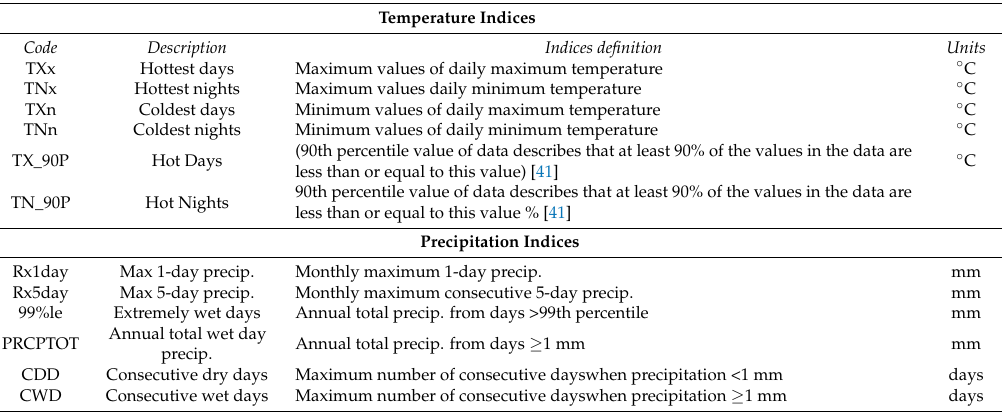
Table 2. Extreme indices of temperature and